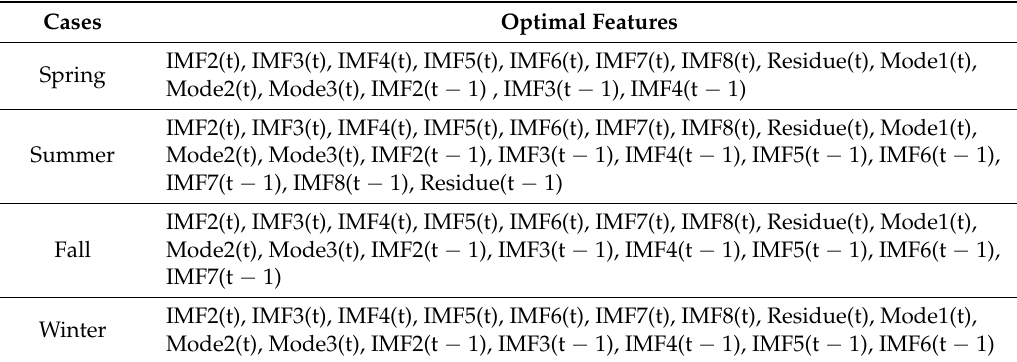
Figure 8. Validation errors of feature selection in the four cases. Table 5. The optimal feature combinations of training samples in four cases.